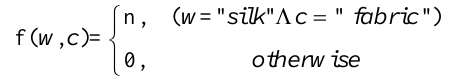
T HE ACCURACY OF THE CLASSIFIER WHEN USING TWO DIFFERENT WAYS OF GENERATING TEXT FEATURES ways of generating The right text features